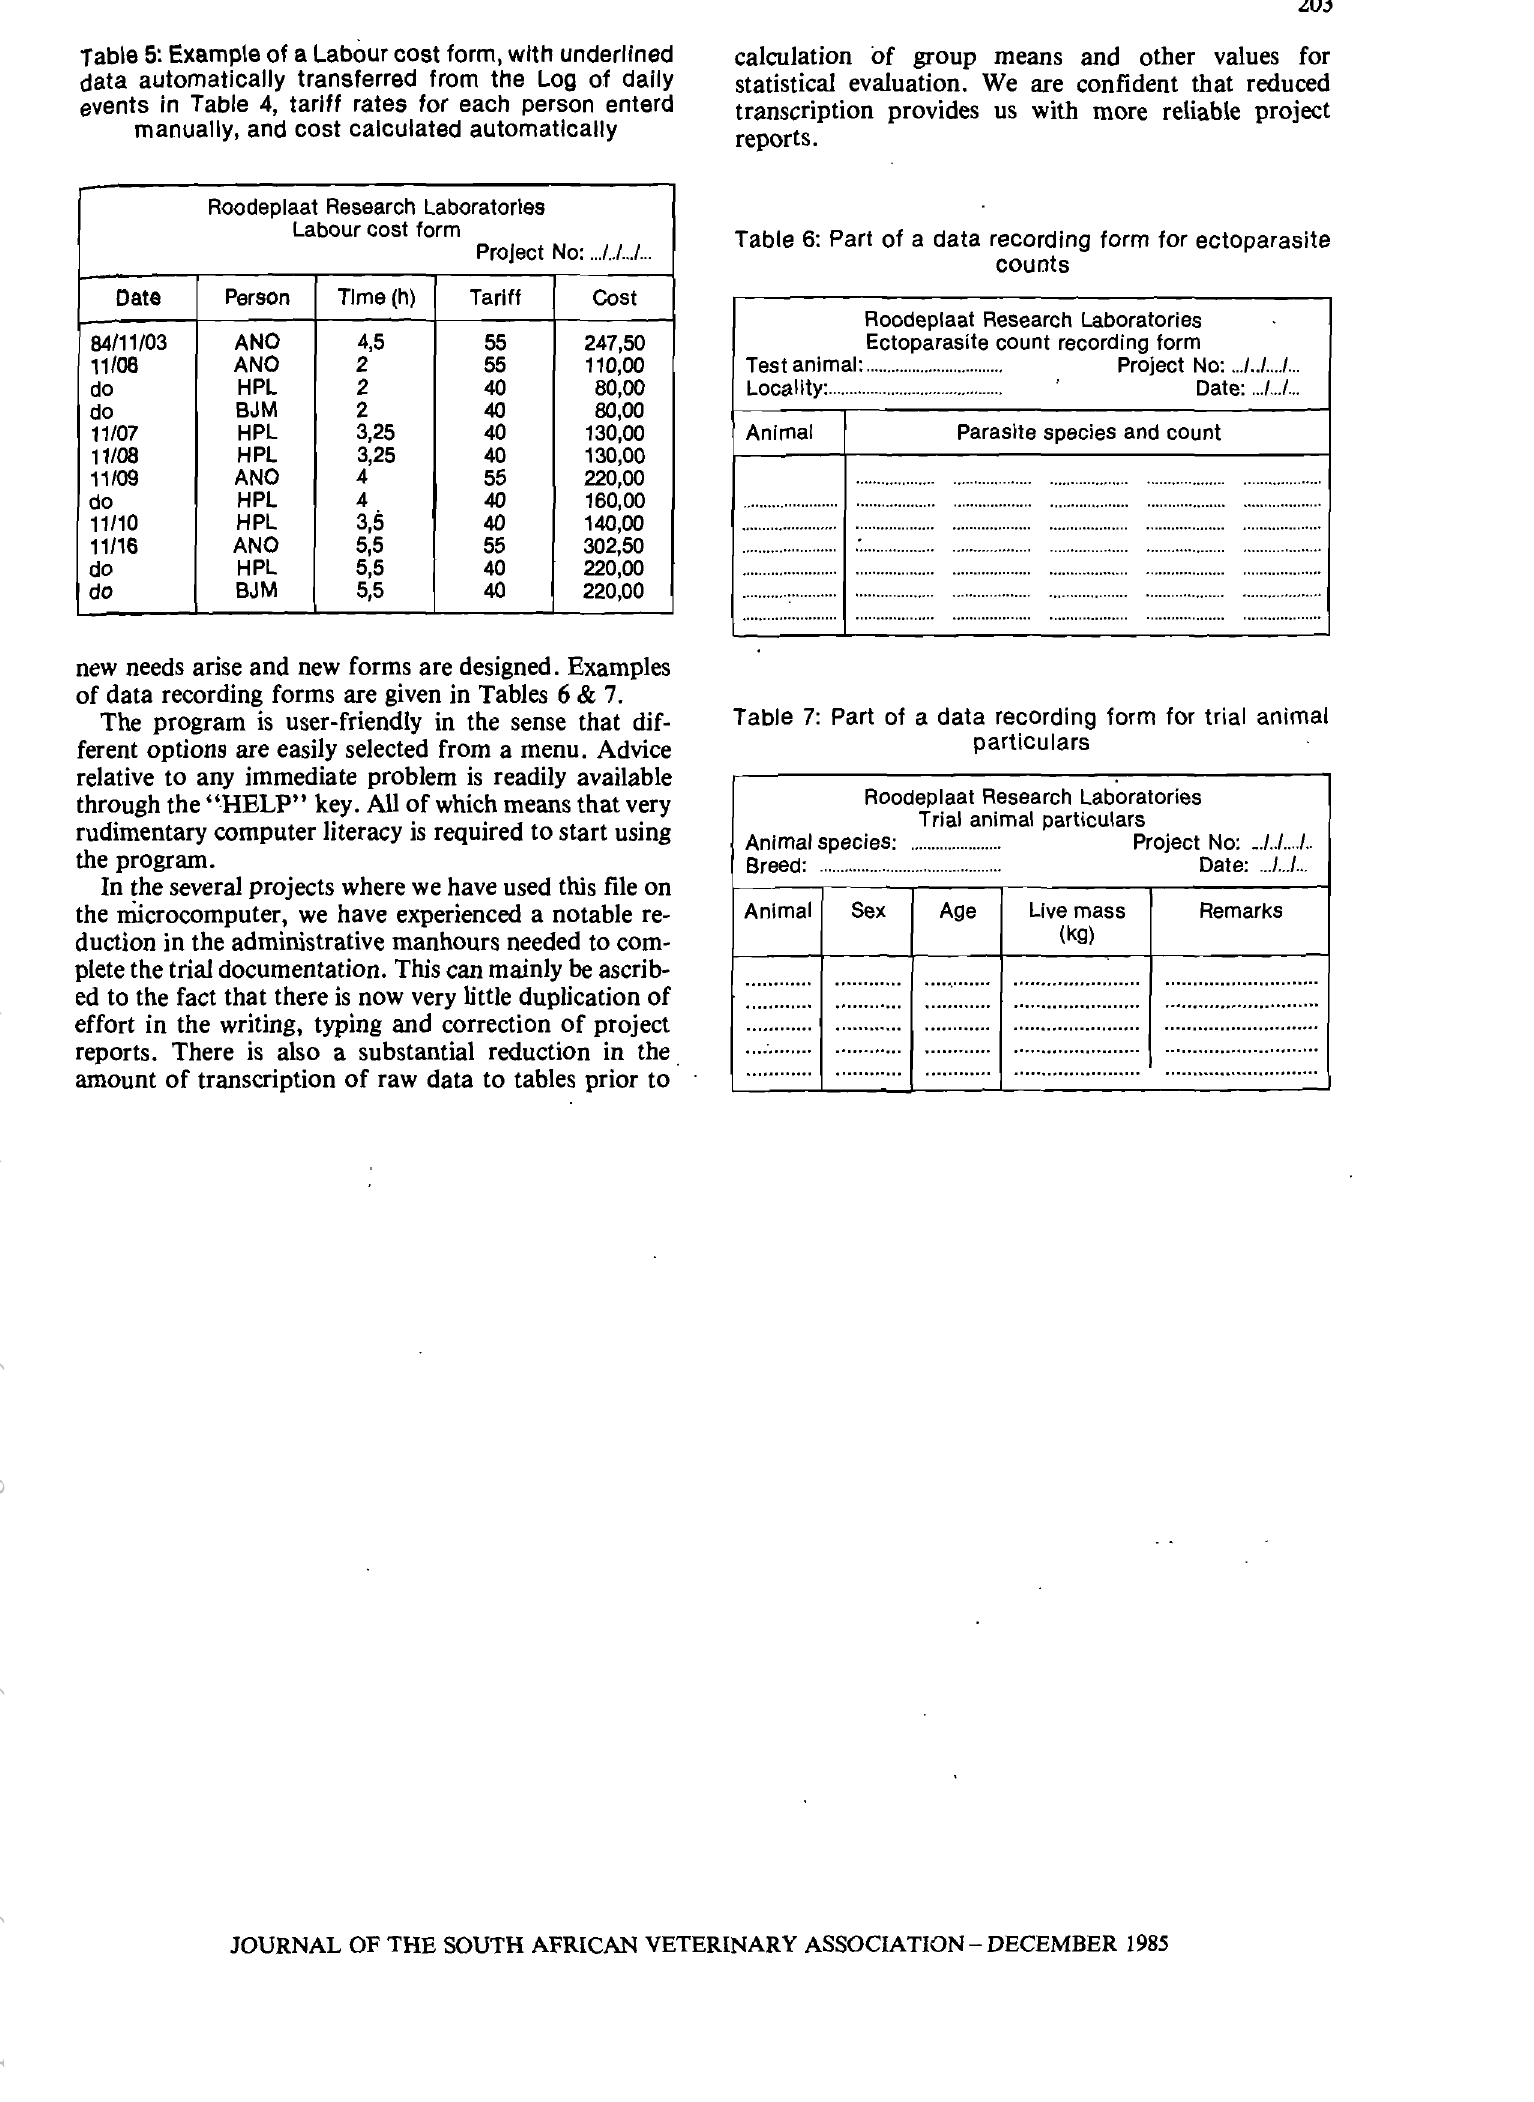
Table 5: Example of a Labour cost form, with underlined data automatically transferred from the Log of daily events in Table 4, tariff rates for each person enterd manually, and cost calculated automatically